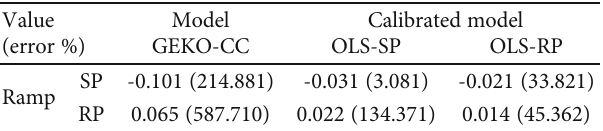
Table 13: Value and error of QoIs corresponding to each calibrated model (24-deg compression ramp).